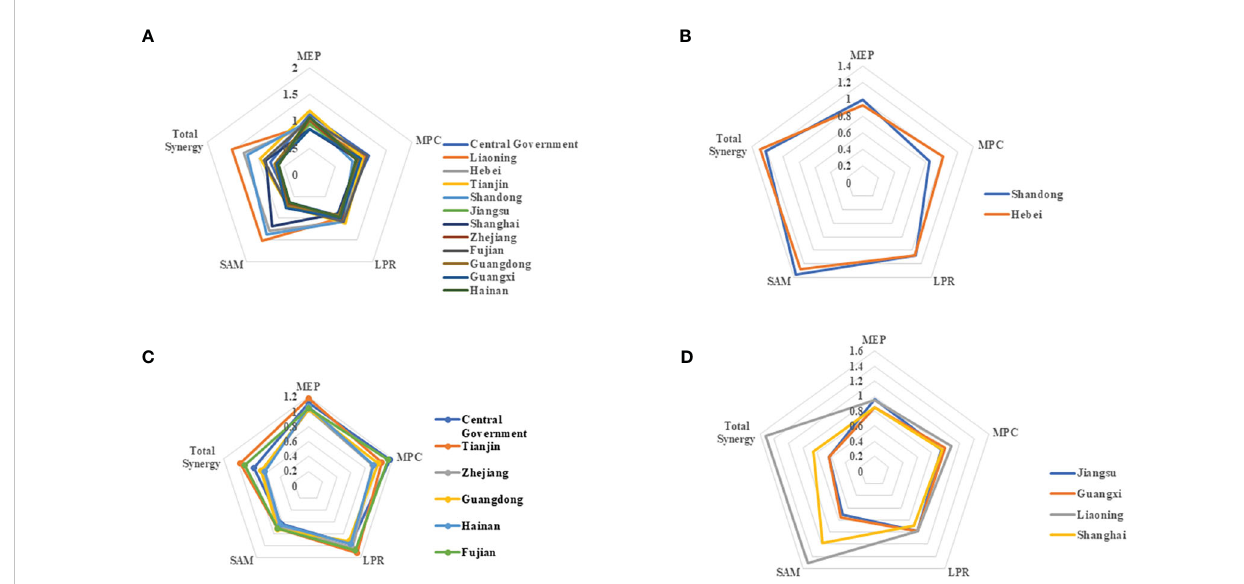
FIGURE 9 Content Synergy Distribution: (A) the degree of all governments, (B) the degree of single-core governments, (C) the degree of multi-core governments, (D) the degree of vertical synergistic